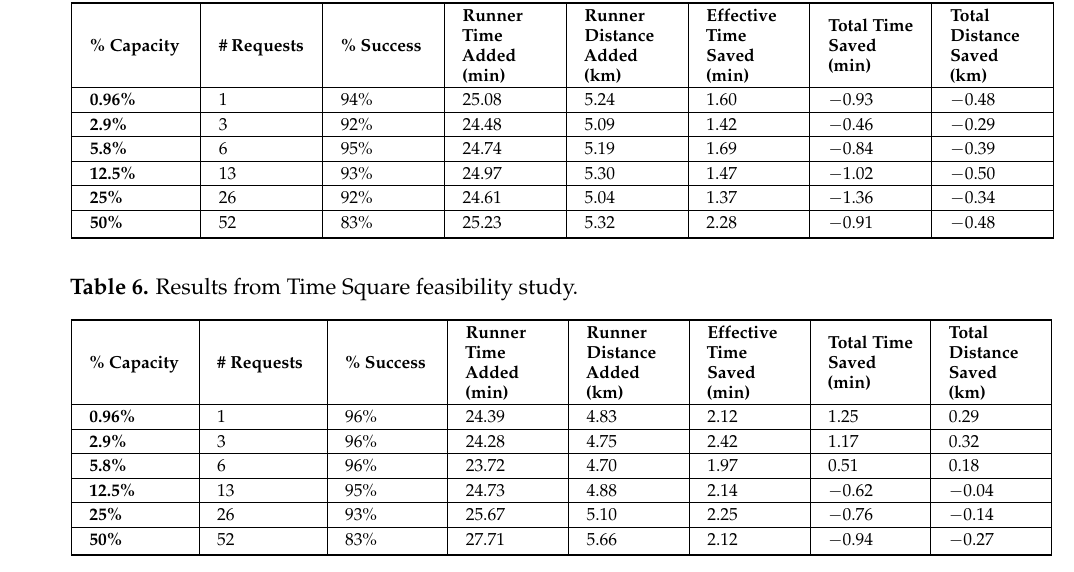
Figure 4. ( a ) presents a comparison between the UCI campus results and the four different areas extracted from the NYC dataset. ( b ) presents instead the average distance saved by all the users, while ( c ) analyzes the success ratio of the system [21] ©2020 IEEE. Table 5. Results from East Village feasibility study.